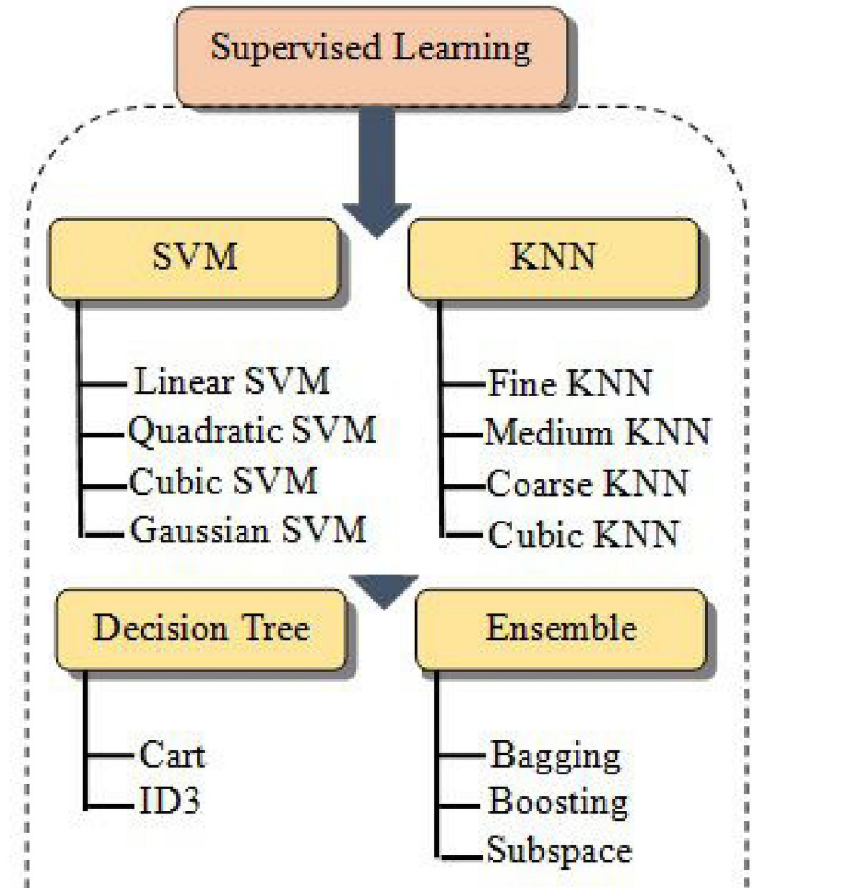
Fig 1. Classification of SML algorithms. These methods are in a supervised